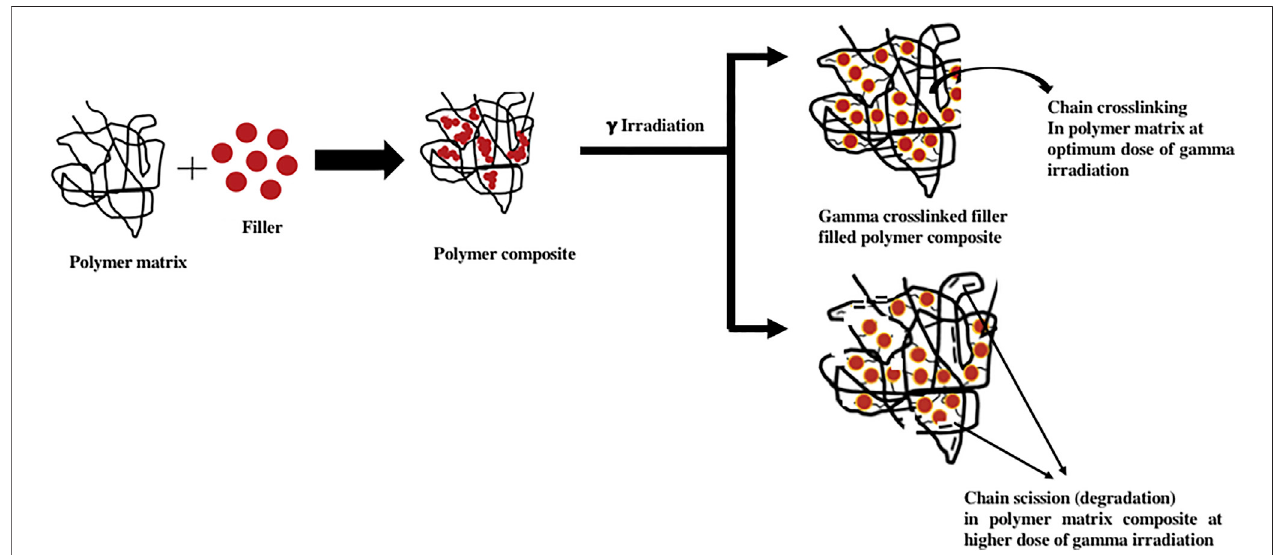
FIGURE 4 | Schematic diagram of gamma irradiation chain crosslinking and scission phenomenon in fi lled reinforced polymer composite.